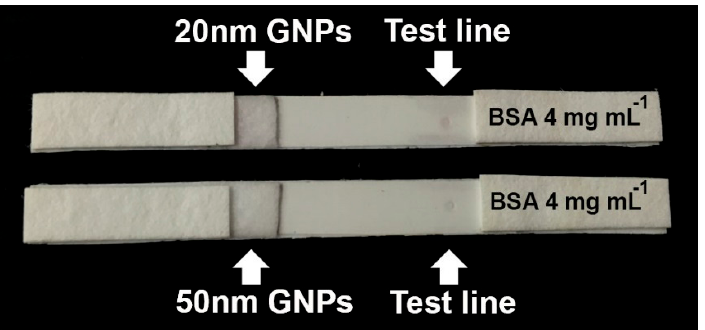
Figure 6. Use of non-conjugated GNPs (sizes of 20 and 50 nm) to detect spotted BSA molecules (concentration = 4 mg mL − 1 ) on the test line.